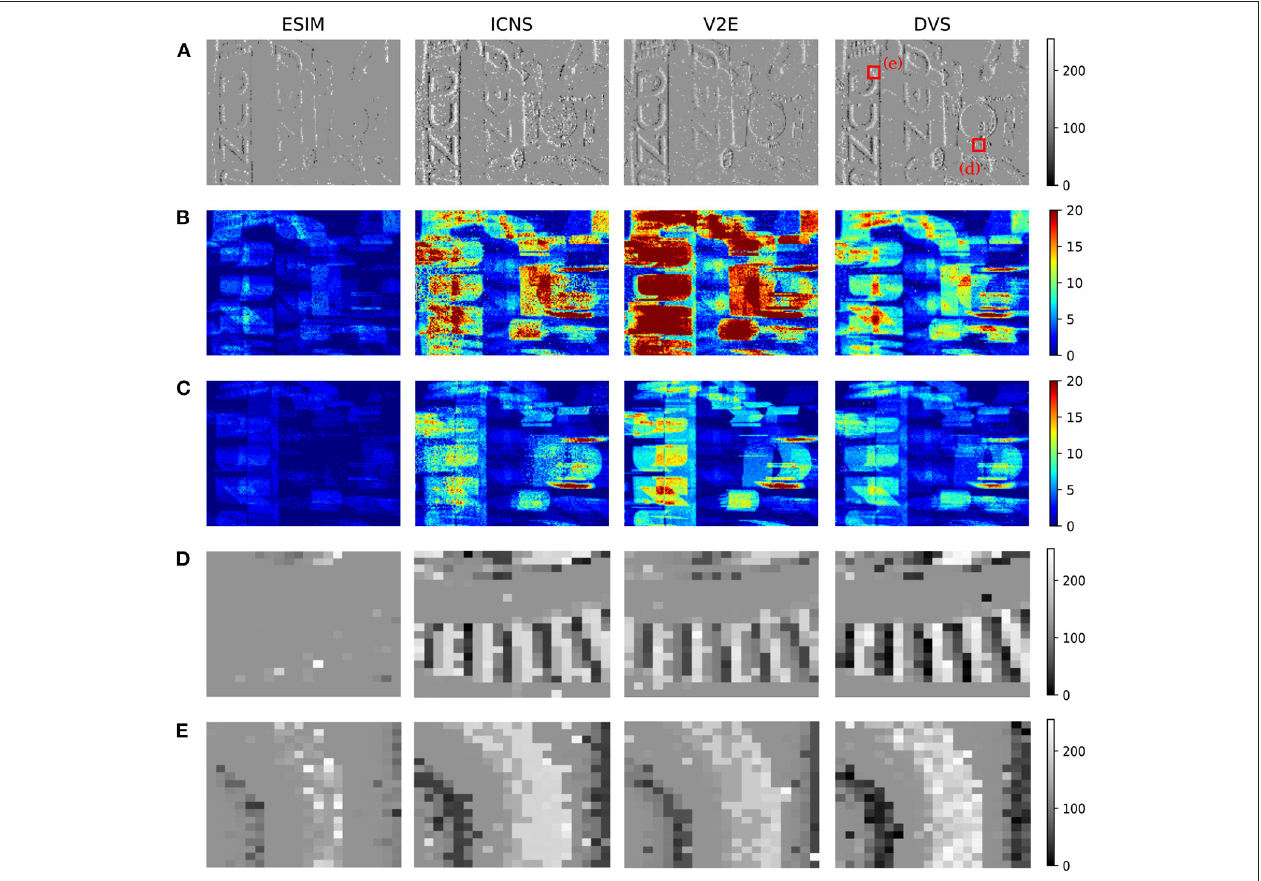
FIGURE 8 | Comparison of the events generated using the different simulators with real DVS events. The input data are provided using the frames acquired with a DAVIS. (A) Comparison of the events integrated though a time surface (time constant 100 µ s ). (B,C) Number of positive–negative events generated during the sequence. (D,E) Magnifications of the time surface. The column DVS corresponds to the real events generated by the DAVIS.